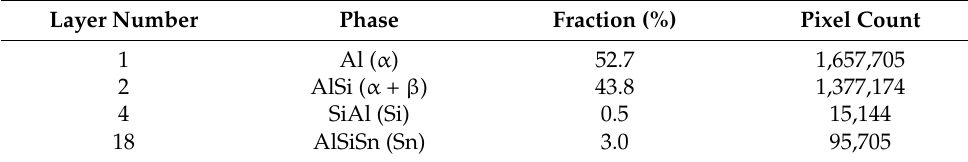
Table 9. Phases in AlSI10Sn1.7 alloy in micro area from Figure 20.